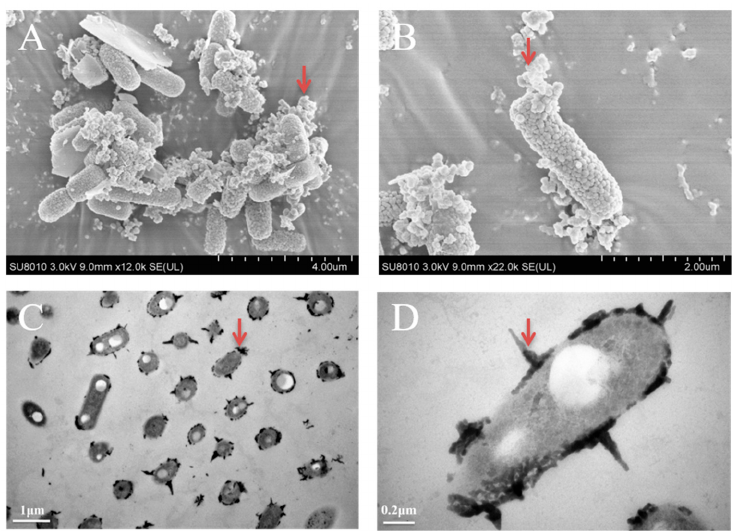
Figure 3. Morphological characteristics of strain F1. ( A , B ) Surface morphology of cell wall by FETEM. ( C , D ) Profile morphology of the cell wall by TEM. Arrows refer to the iron encrustation.